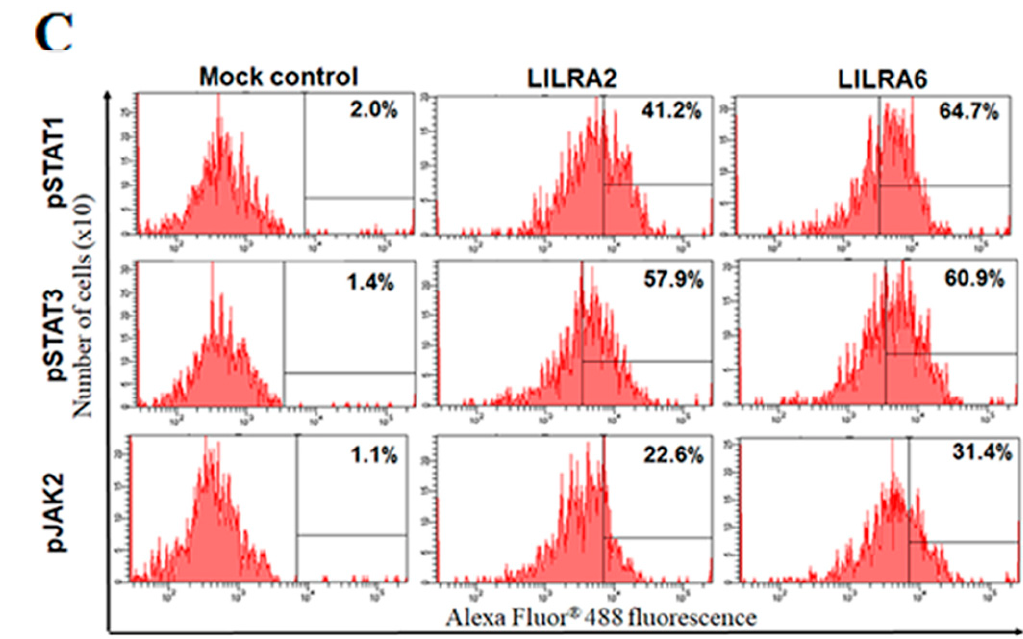
Figure 5. Chicken LILRA2 and LILRA6 regulate the JAK-STAT signaling pathway. ( A ) Western blot of phosphorylated and un-phosphorylated STAT1, STAT3, JAK2 and TYK2 in LILRA2 and LILRA6 transfected HD11 cells; ( B ) qRT-PCR expression of STAT1, STAT3, JAK2 and TYK2 in LILRA2 and LILRA6 transfected HD11 cells; ( C ) FACS analysis of phosphorylated STAT1, STAT3 and JAK2 in LILRA2 and LILRA6 transfected HD11 cells. Data are presented as the mean ± SEM of three independent experiments: * p < 0.05, ** p < 0.01 and *** p < 0.001.